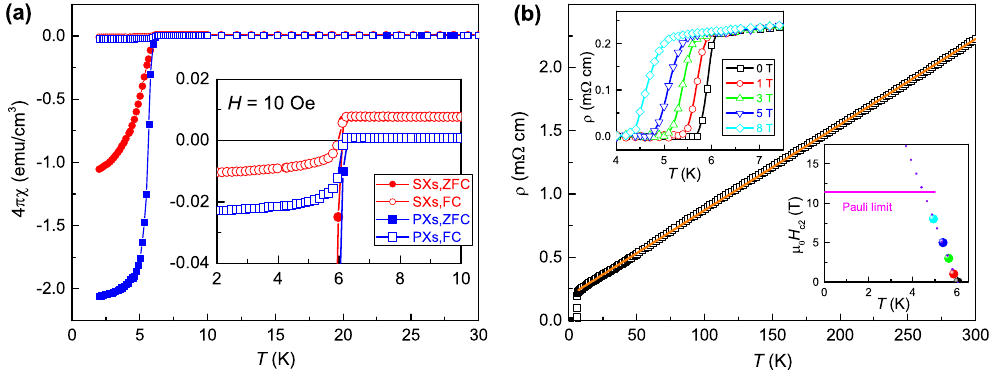
FIG. 3. Superconductivity in K 2 Cr 3 As 3 . (a) Temperature dependence of dc magnetic susceptibility for K 2 Cr 3 As 3 single crystals (SXs) and polycrystals (PXs). The demagnetization effect was not taken into consideration. ZFC and FC denote zero-field cooling and field cooling, respectively. The inset magnifies the FC curves. (b) Temperature dependence of resistivity for the K 2 Cr 3 As 3 polycrystalline sample. The orange line is the linear fit for the normal state. The upper left-hand inset shows the superconducting transitions under different magnetic fields up to 8 T, from which the upper critical field ( H c 2 ) is derived (shown in the lower right-hand inset). The Pauli limit for H c 2 is marked by the horizontal line.